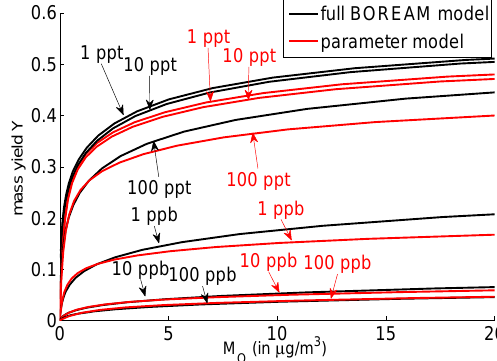
Fig. 7. Net SOA mass yields near SOA equilibrium calculated by the full (black) and parameterised (red) model at NO 2 levels be- tween 1ppt and 100ppb, for OH-oxidation of α -pinene (at